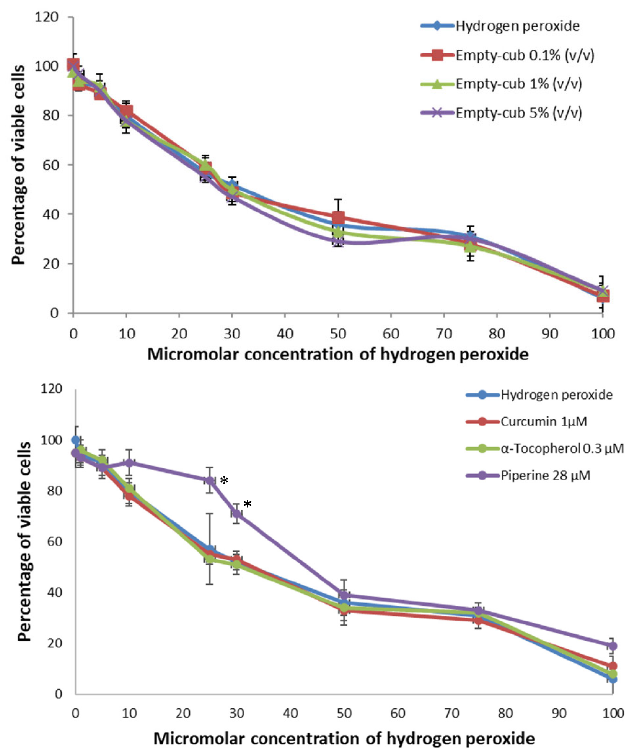
Figure 4. Top to bottom, Antioxidant activity of Empty-cub nanocarriers. The nanocarriers do not have any effect towards hydrogen peroxide at the tested concentrations. No values were statistically different in comparison to hydrogen peroxide. Antioxidant activity of non-cytotoxic concentrations of solutions of Curcumin, α‐ Tocopherol and Piperine. * Values are statistically different versus hydrogen peroxide p < 0.05.